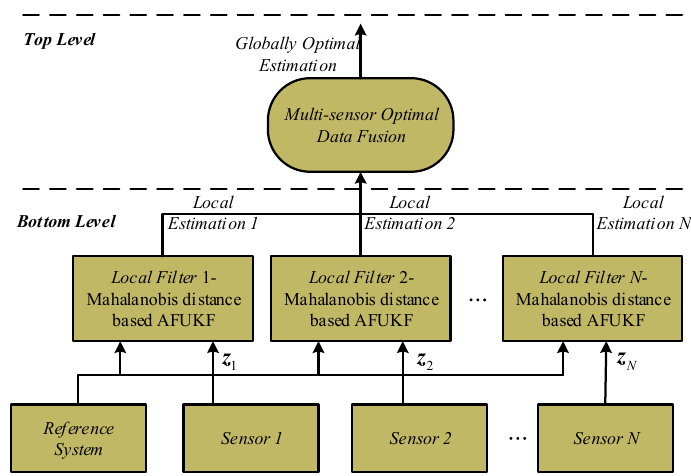
Figure 1. The framework of the proposed AFUKF-based multi-sensor optimal data